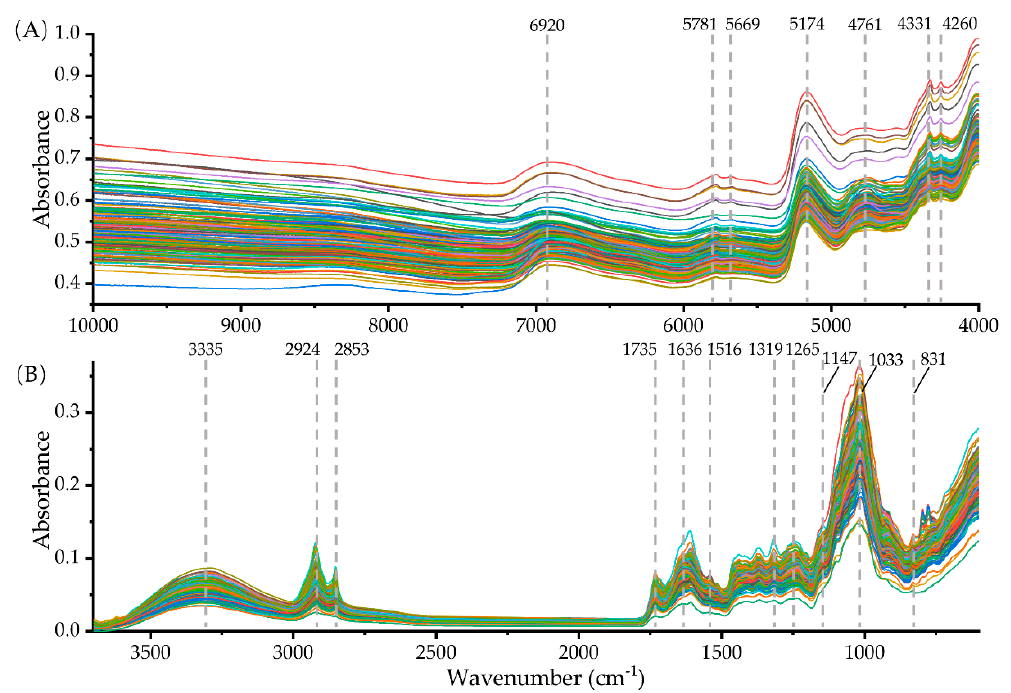
Figure 1. Raw near-infrared (NIR) ( A ) and Fourier transform mid-infrared (FT-MIR) ( B ) spectra of 180 samples of G. rigescens and its related species.